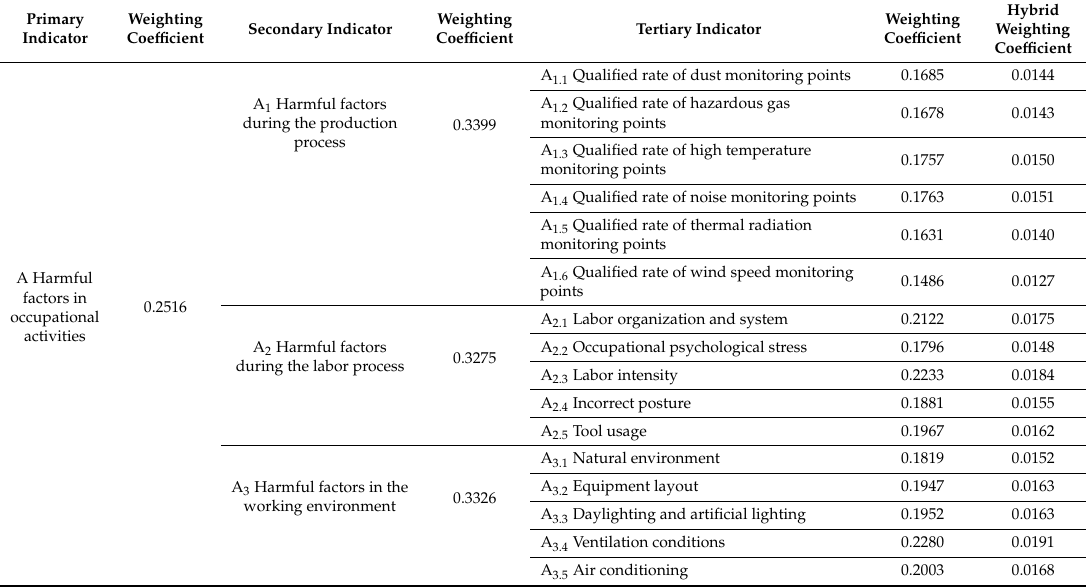
Table 4. Weighting coe ffi cients of comprehensive evaluation